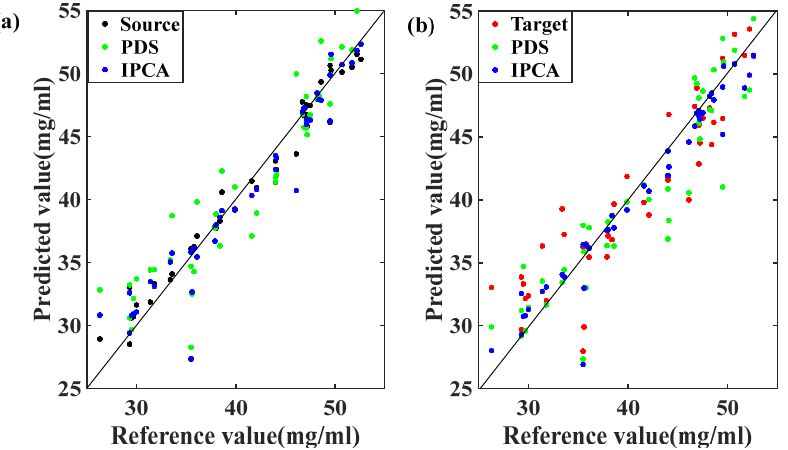
Figure 8. ( a ) Relationship of reference and predicted value in validation set obtained by ( a ) source— transferred target (PDS) or (IPCA), ( b ) target—transferred source (PDS) or (IPCA).